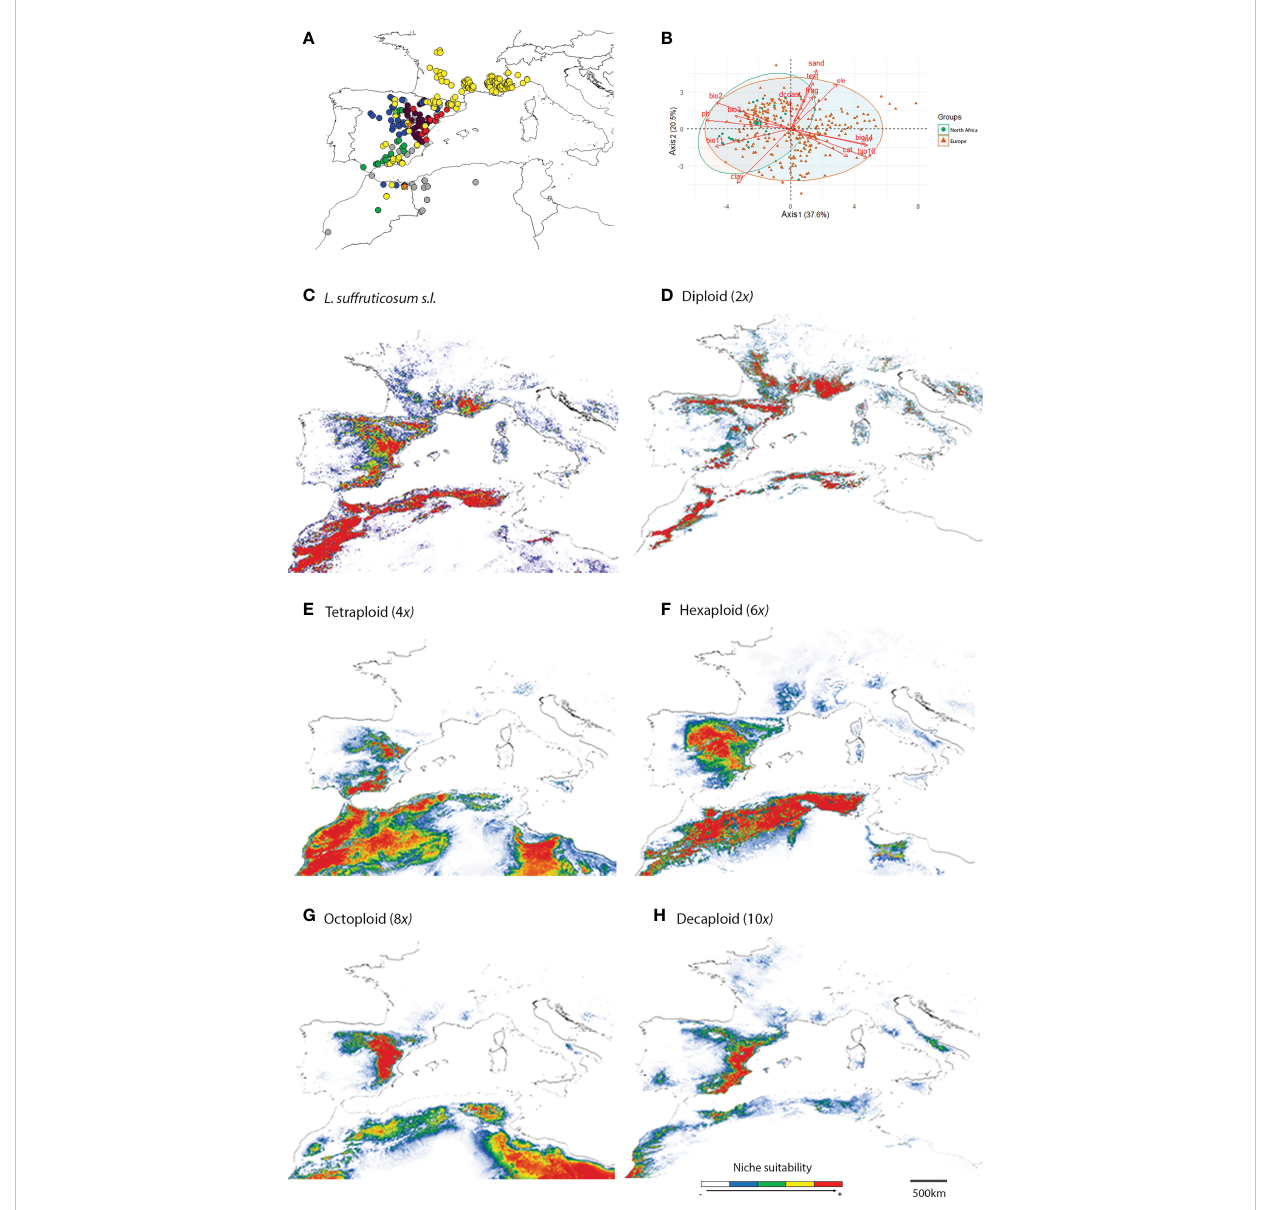
FIGURE 1 Distribution of Linum suffruticosum s.l. cytotypes: diploids, yellow circles; tetraploids, green circles; hexaploids, blue circles; octoploids, purple circles; decaploids, red circles; diploid-tetraploid mixed-ploidy population, orange star; hexaploid-tetraploid mixed-ploidy population, green star; without cytotype information, grey circles (A) ; Principal Component Analysis (PCA) of all variables (Precipitation of Driest Month, bio14; Precipitation of Wettest Quarter, bio16; Mean Temperature of Coldest Quarter, bio11; Mean Diurnal Range, bio2; Isothermality, bio3; elevation, ele; Distance to the coast, dcoast; soil water capacity at 15 cm, aw; Fragment content at 15 cm, frag; Clay content at 15 cm, clay; Soil pH at 30 cm, ph; Sand content at 15 cm, sand; Cation exchange capacity at 15 cm, cat; Soil texture at 15 cm, text) for Europe, and North Africa (B) ; and habitat suitability for L. suffruticosum s.l. (C) , and for diploids (D) ; tetraploids (E) ; hexaploids (F) ; octoploids (G) , and decaploids (H)